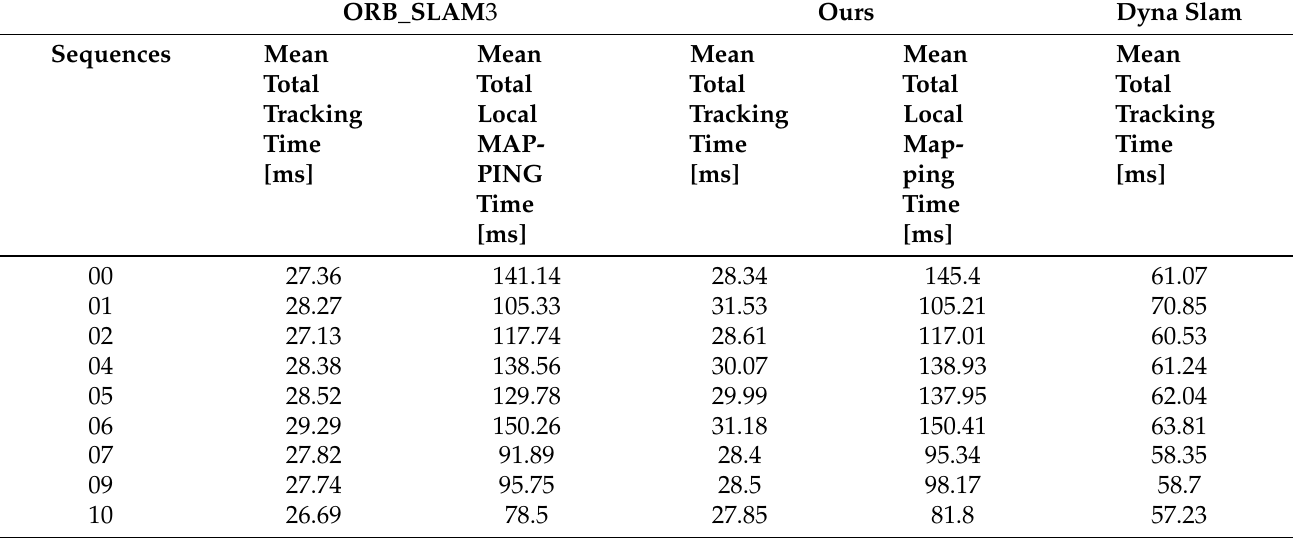
Table 9. Real-time comparison of ORB_SLAM3, our system, and Dyna